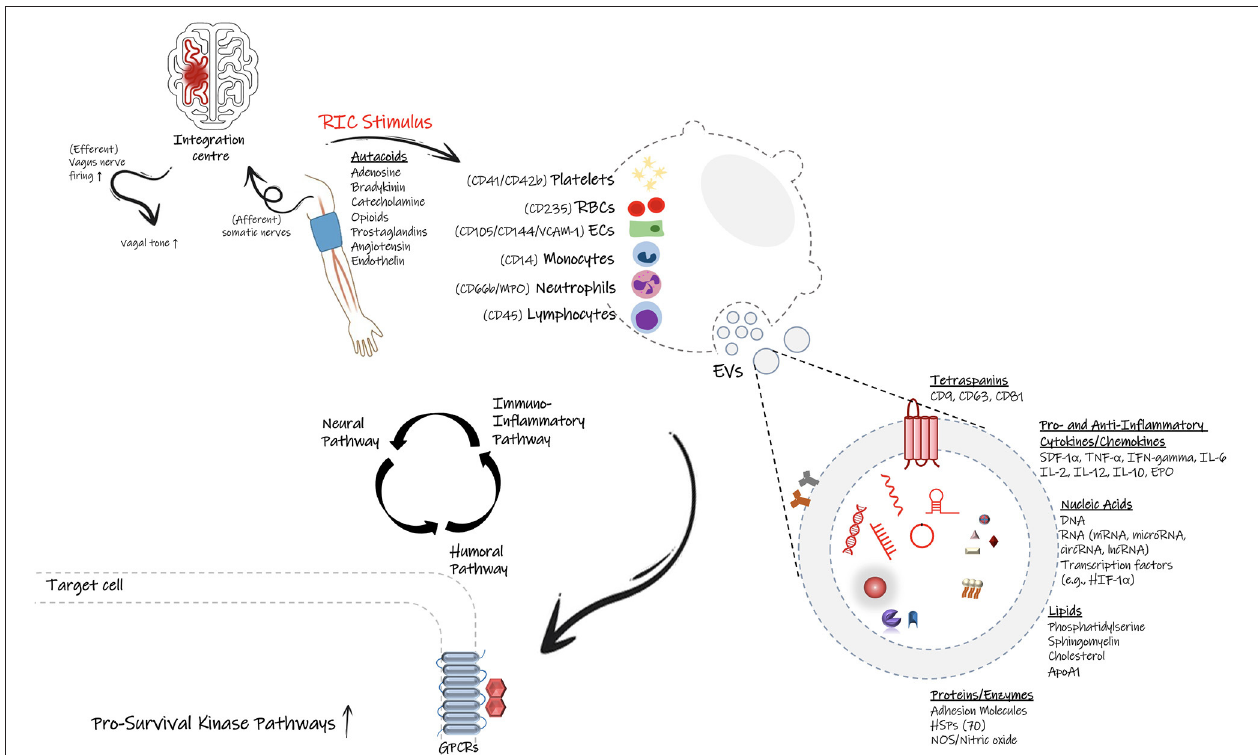
FIGURE 1 | Proposed signal transmission pathways during remote ischemic conditioning (RIC). Following application of RIC protocol on the upper arm, the initiated protective signal appears to involve a complex and overlapping activation of neural pathways (autonomic nervous system), humoral mediators, and the peripheral immune system. It is proposed that small endogenous particles called extracellular vesicles (EVs) can facilitate the transfer of protective effects of RIC through the flow stream. Many cell types including endothelial cell, immune cells as well as platelets can generate EVs with signature surface markers and cargo defined based on the parent cell and the physio/pathophysiological conditions. EVs can carry cytokines, chemokines, genetic material and many more biological substrates, which allow them to inter-connect distant cells, tissues or organs and affect the target cells’ transcriptional profiles and likely their function and phenotype. Based on the stimulus, they can deliver either proinflammatory or anti-inflammatory factors, therefore modulate the immune response and the fate of recipient